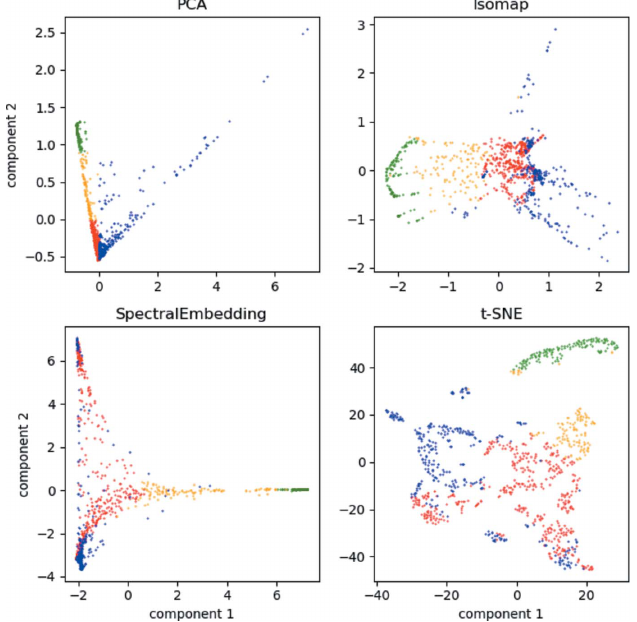
Figure 7 Comparison between four different common dimensionality reduction methods, (top left) PCA, (top right) isomap, (bottom left) spectral embedding and (bottom right) t-SNE. Colour coding is same as in Fig. 2 by manually divided groups from the first two components of PCA